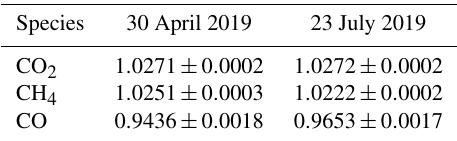
Table 3. Scaling factors γ for EM27/SUN XCO 2 , XCH 4 , and XCO observations as derived from the side-by-side measurements at the TCCON station Karlsruhe (Eq. 8). The uncertainty is the standard error of the mean of the hourly data (Eq.